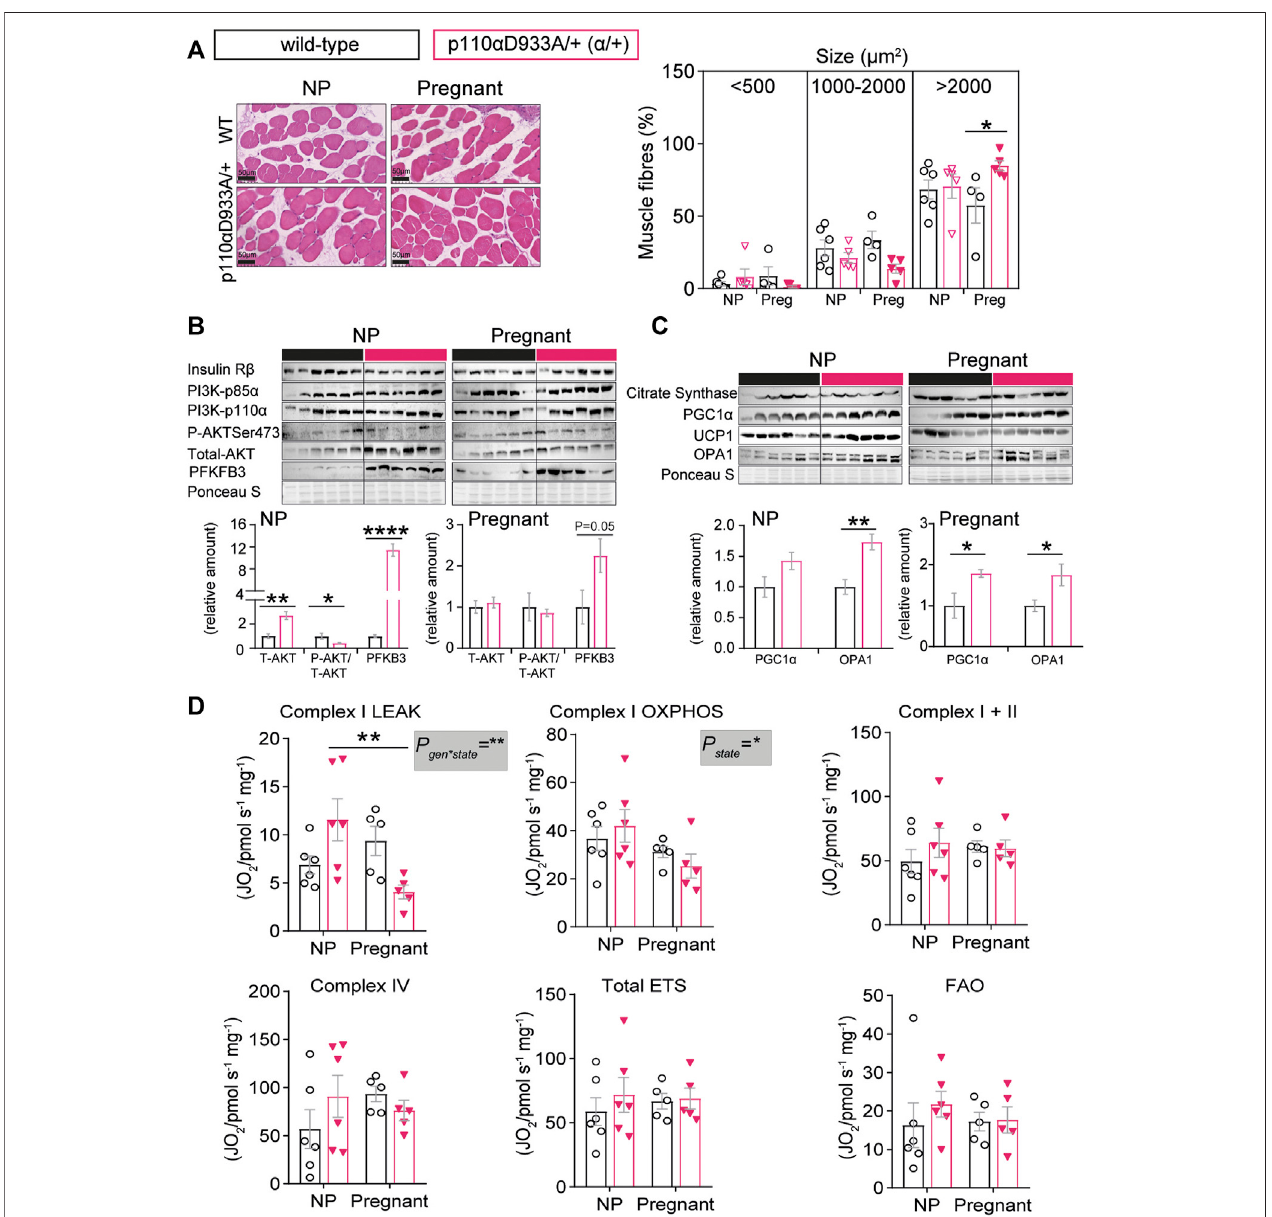
FIGURE 4 | PI3K-p110 α regulates myo fi bre size and mitochondrial metabolism. (A) Skeletal muscle fi bre size in non-pregnant (NP) and pregnant mice ( n = 4 – 6/ group; two-way ANOVA) (scale bar = 50 μ m). (B,C) Western blot analysis of metabolic signalling pathways in the skeletal muscle: insulin receptor β subunit (Insulin R β ), phosphoinositide-3-kinase subunits (PI3K-p85 α and PI3K-p110 α ), total and phosphorylated protein kinase B (Total AKT and P-AKTSer473) and 6-phosphofructo-2- kinase/fructose-2,6-biphosphatase 3 (PFKFB3), peroxisome proliferator-activated receptor gamma coactivator 1-alpha (PGC1 α ), mitochondrial brown fat uncoupling protein 1 (UCP1) and mitochondrial dynamin like GTPase (OPA1) ( n = 6/group; un-paired Student ’ s t -test). (D) Mitochondrial respirometry ( n = 5 – 6/group; two-way ANOVA). Information about substrate/inhibitor in relation to complex activation can be found in SupplementaryTable S1 . Maximum electron transfer system capacity (Total ETS) and fatty acid oxidation (FAO). Data are individual values and/or mean ± SEM. * p < 0.05; ** p < 0.01; *** p < 0.001; **** p < 0.0001.